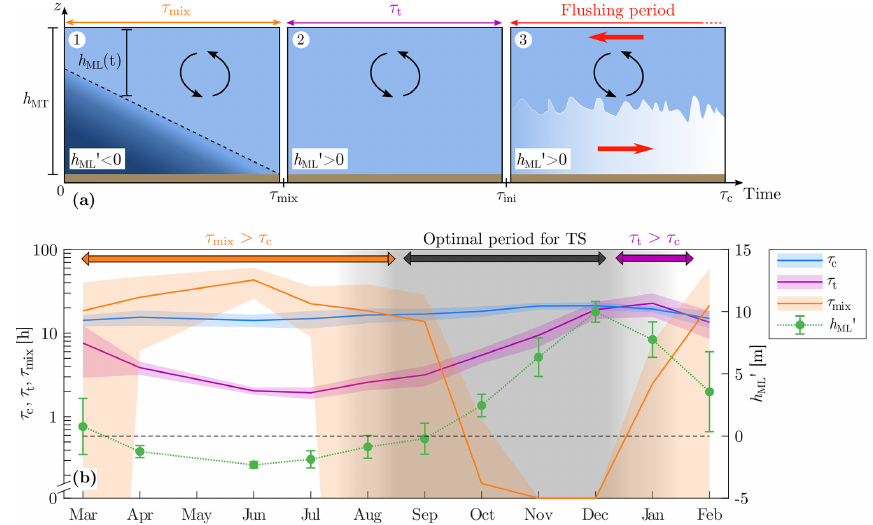
Figure 8. Timescales determining the occurrence of TSs. (a) Schematic of the three periods of the cooling phase at MT (Fig. 3d) parameter- ized by the mixing timescale τ mix , transition timescale τ t , and cooling duration τ c . The mixed-layer depth is expressed as the relative depth = h ML − h MT , with respect to h MT = 4m. The mixed layer deepens during the first period (0 < t < τ h (cid:48) mix ), until the complete mixing of ML the water column. The transition period ( τ mix < t < τ ini ) is dominated by convection. TSs occur during the flushing period ( τ ini < t < τ c ). (b) Effects of the seasonality of τ mix , τ t , τ c , and h (cid:48) on the TS occurrence. Monthly averages are represented, with shaded areas ( τ c , τ t , and ML τ mix ) and error bars ( h (cid:48) ) indicating the monthly standard deviation. Note the log scale for the axis of timescales. The gray shaded period ML corresponds to optimal conditions for the TS